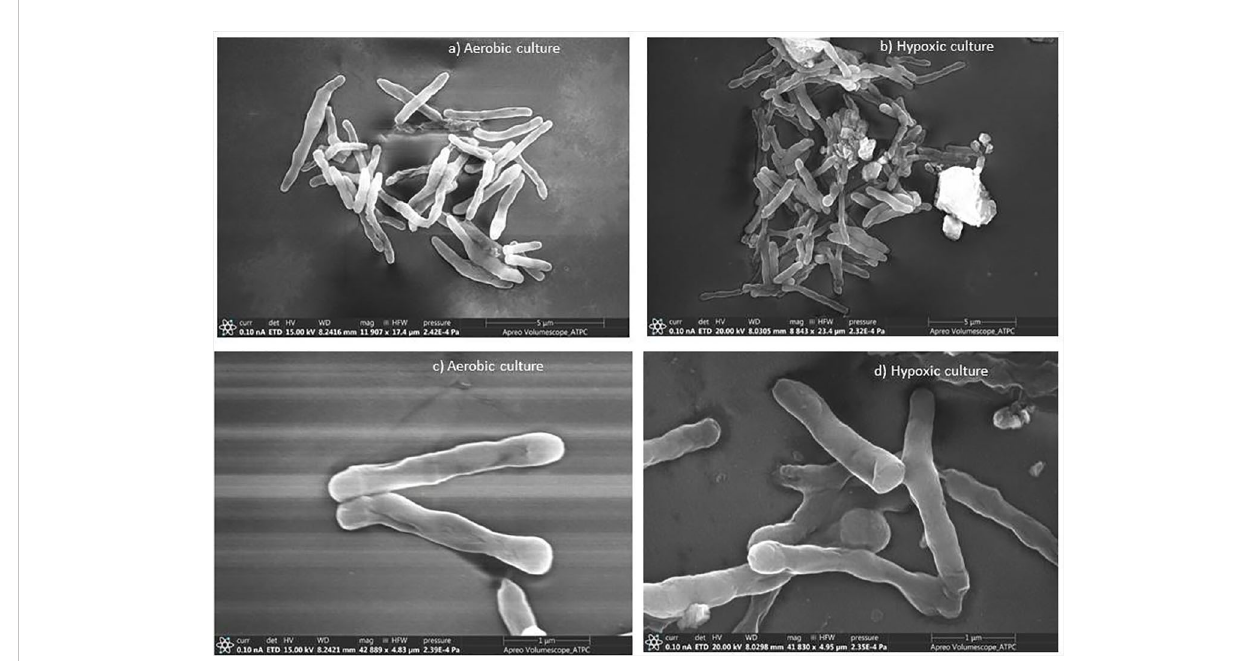
FIGURE 1 Scanning electron micrographs of M. smegmatis under aerobic and hypoxic environment: (A, C) aerobic culture and (B, D) hypoxic